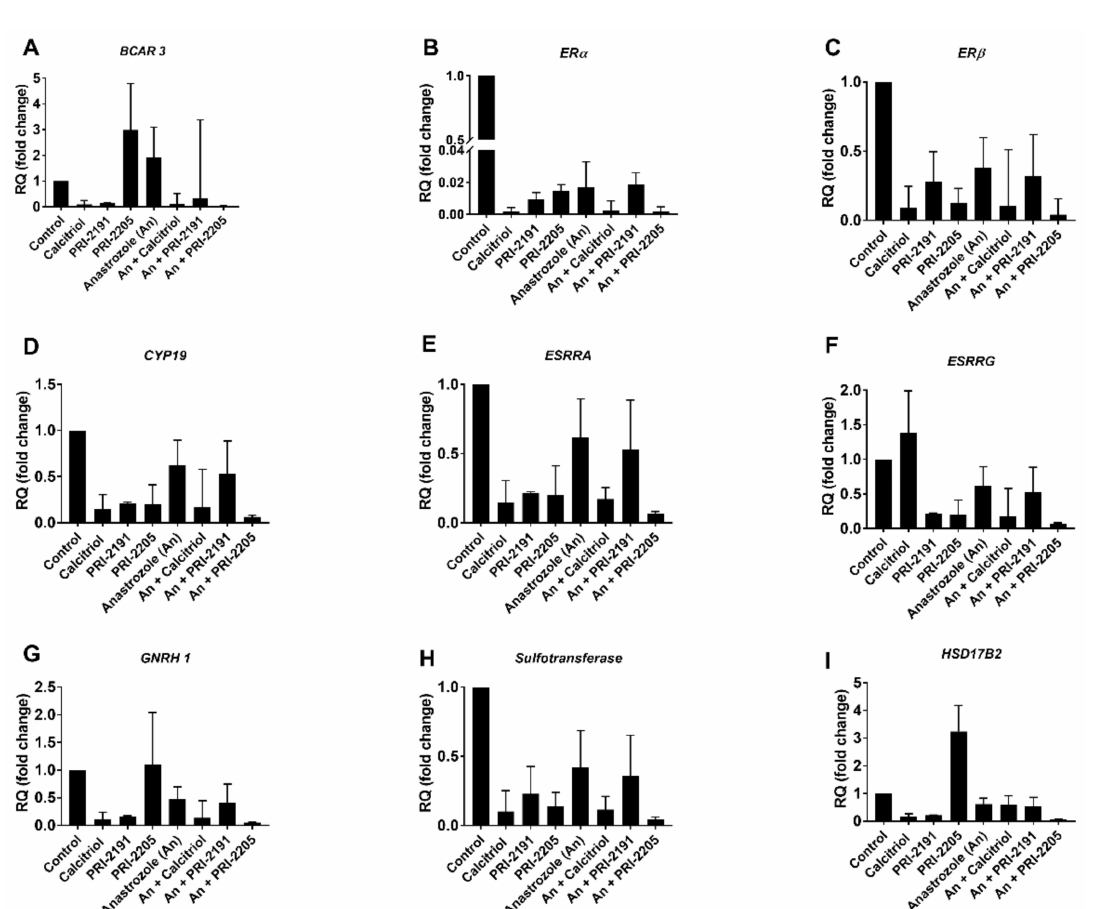
Figure 6. Changes in the mRNA profile of MCF-7 cells after treatment with calcitriol or vitamin D analogs with/without anastrozole. The figures presented above represent genes encoding molecules involved in estrogen metabolism. ( A ) BCAR3—breast cancer antiestrogen resistance protein 3; ( B , C ) ER α , ER β —estrogen receptors α and β , respectively; ( D ) CYP19—aromatase; ( E , F ) ESRRA, ESRRG—Estrogen Related Receptor Alpha and Gamma, respectively; ( G ) GNRH1— Gonadotropin-Releasing Hormone 1; ( H ) SULT1E1—sulfotransferase family 1E, estrogen-preferring member 1; ( I ) HSD17B2—hydroxysteroid dehydrogenase 17 beta 2. PCR analysis was performed for two independent samples (each sample was tested in